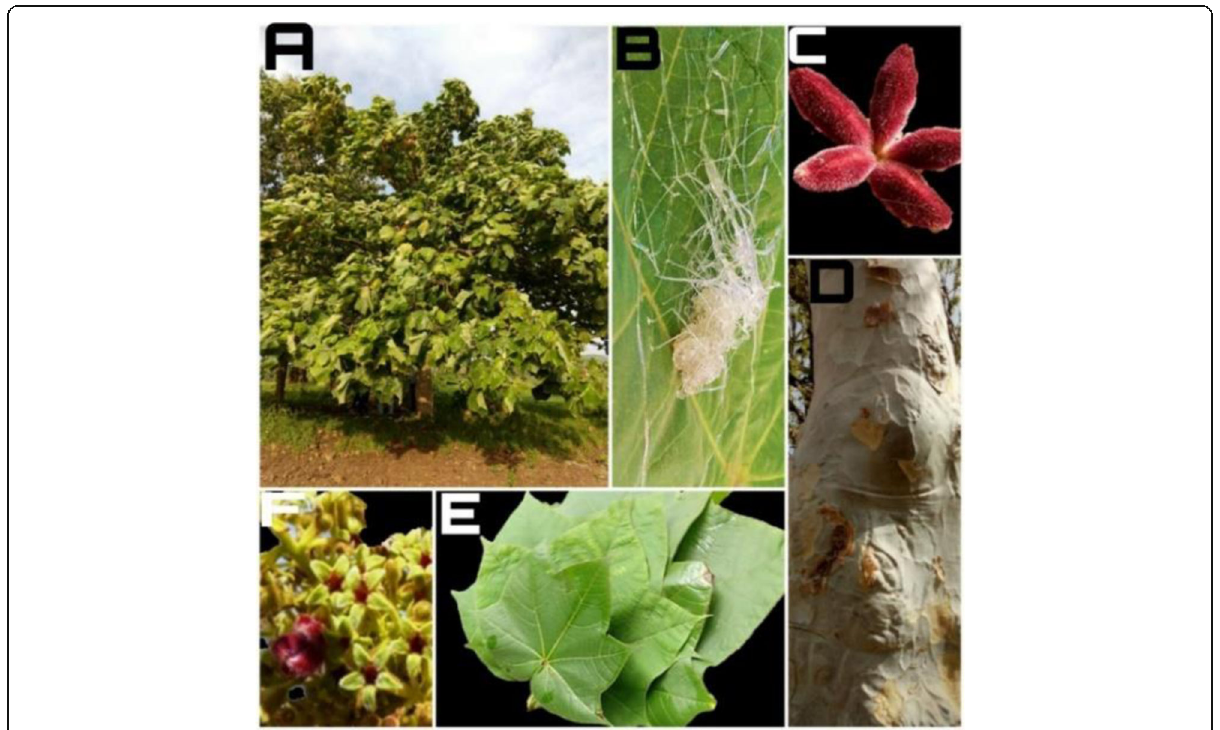
Fig. 1 Sterculia urens Roxb. a Tree. b Karaya gum. c Fruit. d Bark. e Leaf. f Flowers